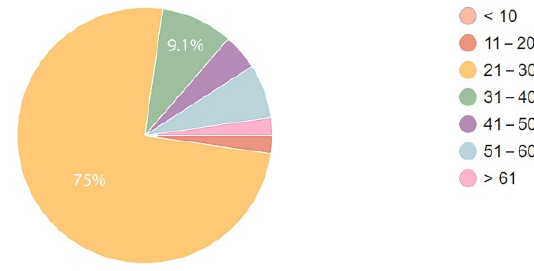
Figure 8. Age of respondent staff.